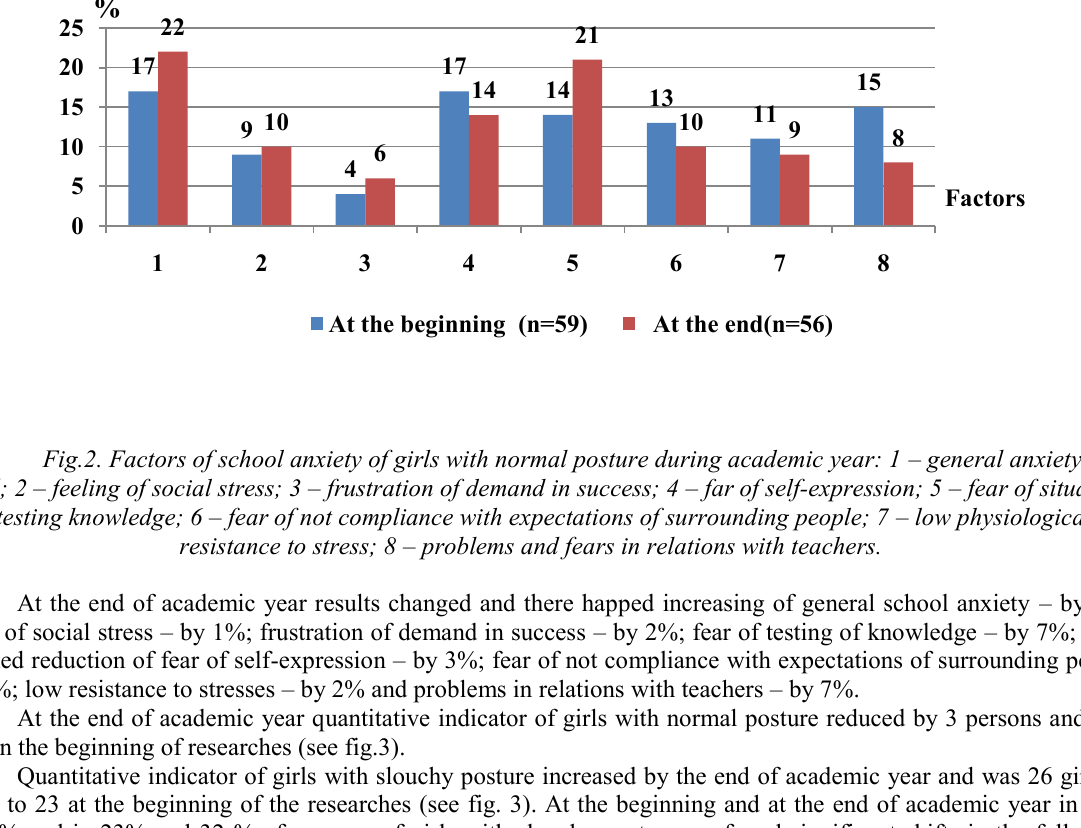
Fig.1. Kinds of postures of 12-13 years old girls at the beginning and at the end of academic year (n=137)